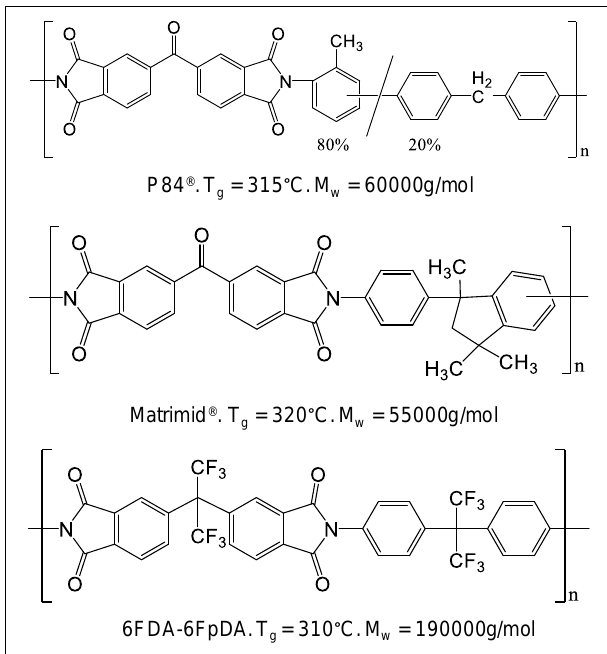
Figure 1. Structures and properties of the polyimides used in this work.